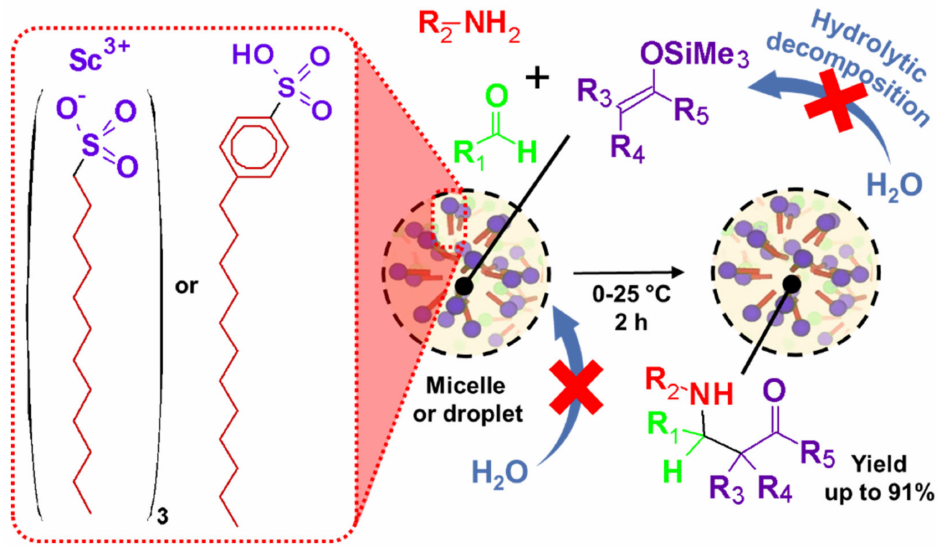
Figure 21. Lewis or Brønsted acid–surfactant-combined catalysts (scandium trisdodecylsulfate or p -dodecylbenzenesulfonic acid) for the synthesis of β -amino carbonyl compounds from three-component Mannich-type reactions of aldehydes, amines, and silyl